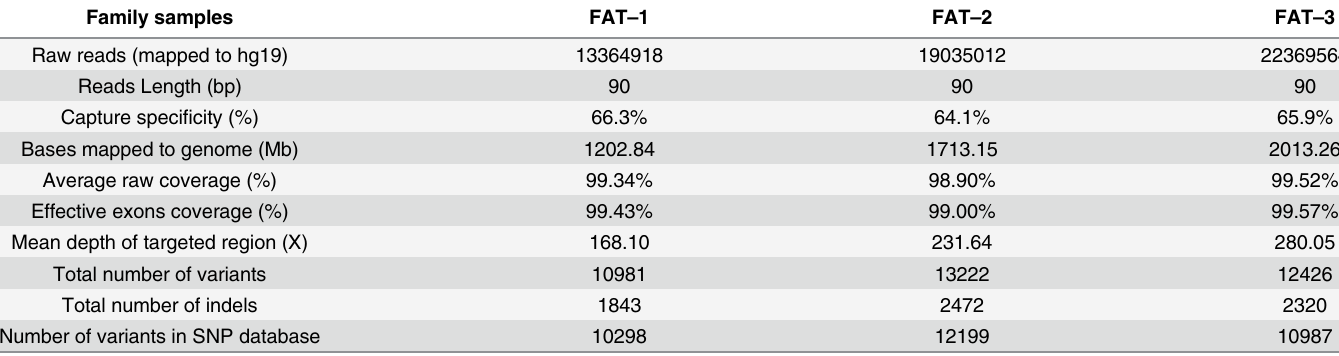
Table 2. Overview of NGS data